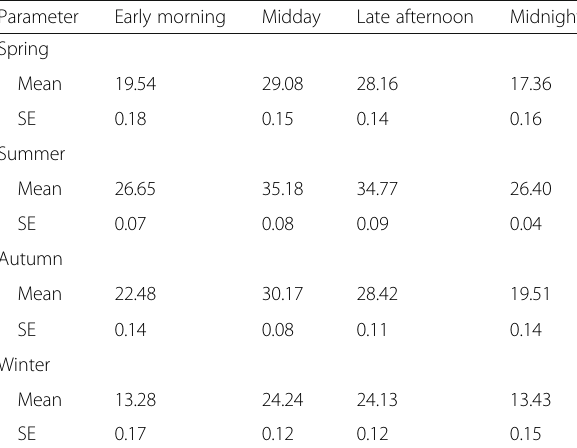
Table 3 Mean and standard error of diurnal and seasonal temperatures (°C) collected by the GPS collars